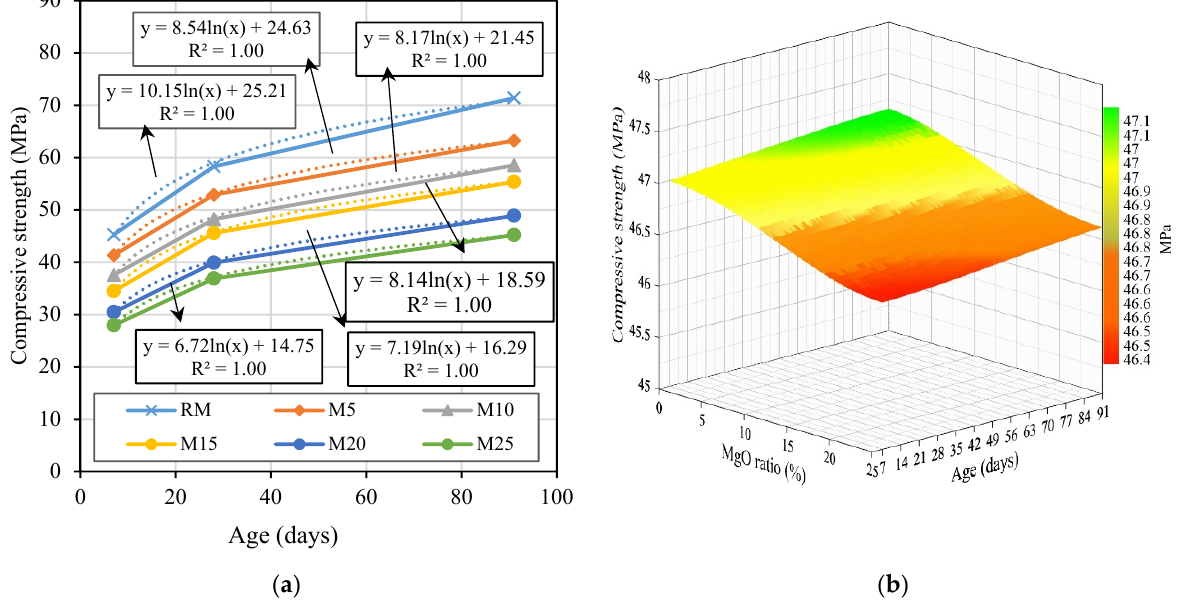
Figure 5. Compressive strength over time of mortars with MgO ( a ); compressive strength over time versus incorporation ratio of MgO ( b ).